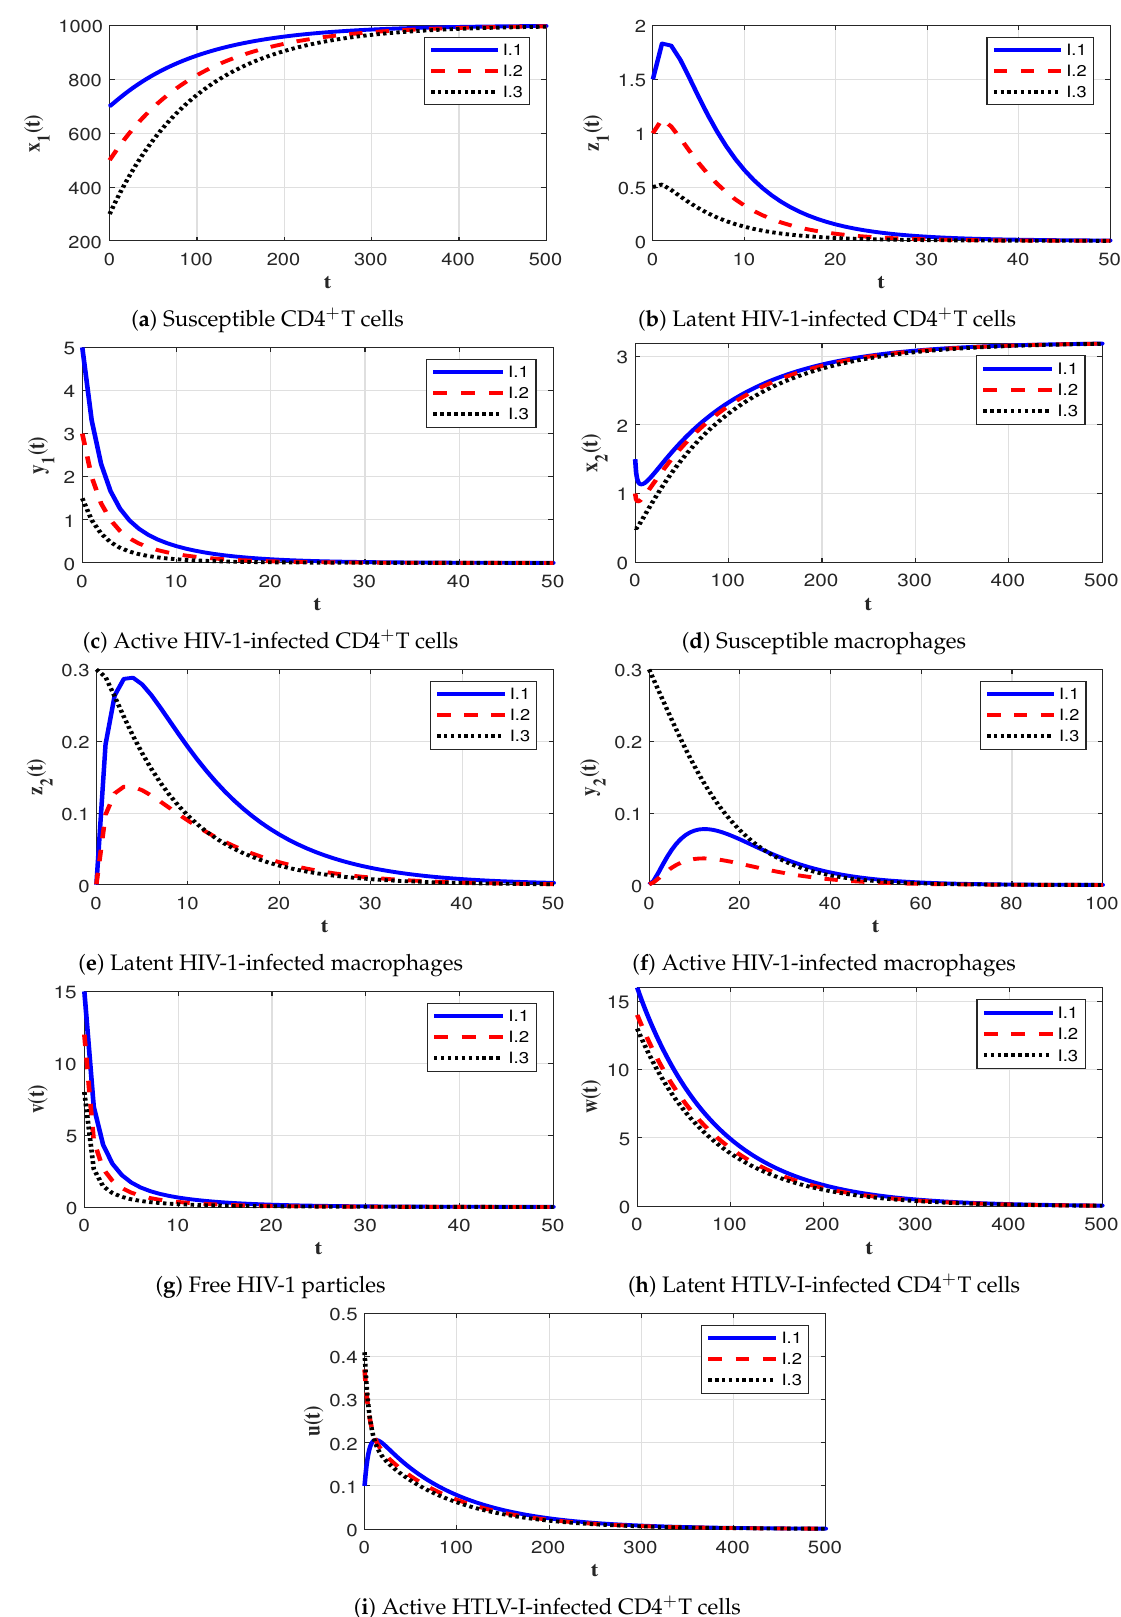
Figure 2. The equilibrium EP 0 = ( 1000,0,0,3.19,0,0,0,0,0 ) is G.A.S whenever R 0 ≤ 1 and R 1 ≤